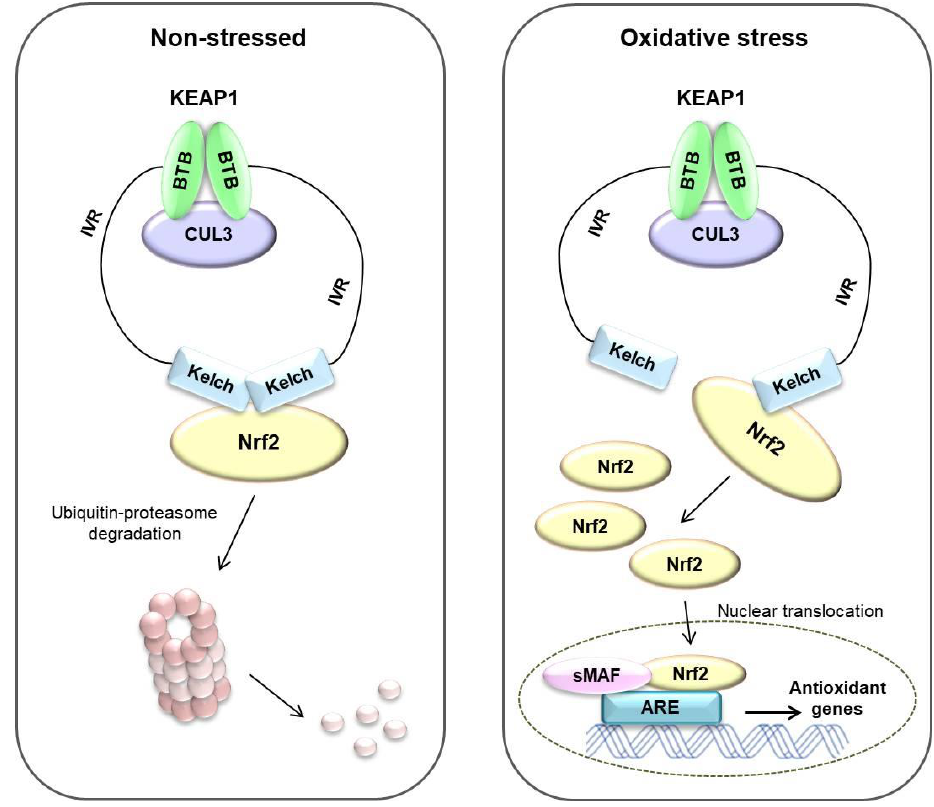
Figure 5. Nrf2/KEAP1 pathway in non-stressed and oxidative stress status. Under non-stressed state, Nrf2 binds to Keap1 by ubiquitin E3 ligase complex. Nrf2 rapidly degrades via ubiquitin–proteasome system. Under oxidative stress state, the ubiquitin E3 ligase activity of the KEAP1-Cul3 complex is reduced, and Nrf2 translocates to the nucleus and is heterologous to the small-MAF (sMAF) protein and binds to ARE. Finally, antioxidant genes are induced by these systems. Adapted from Raghunath et al. [69].